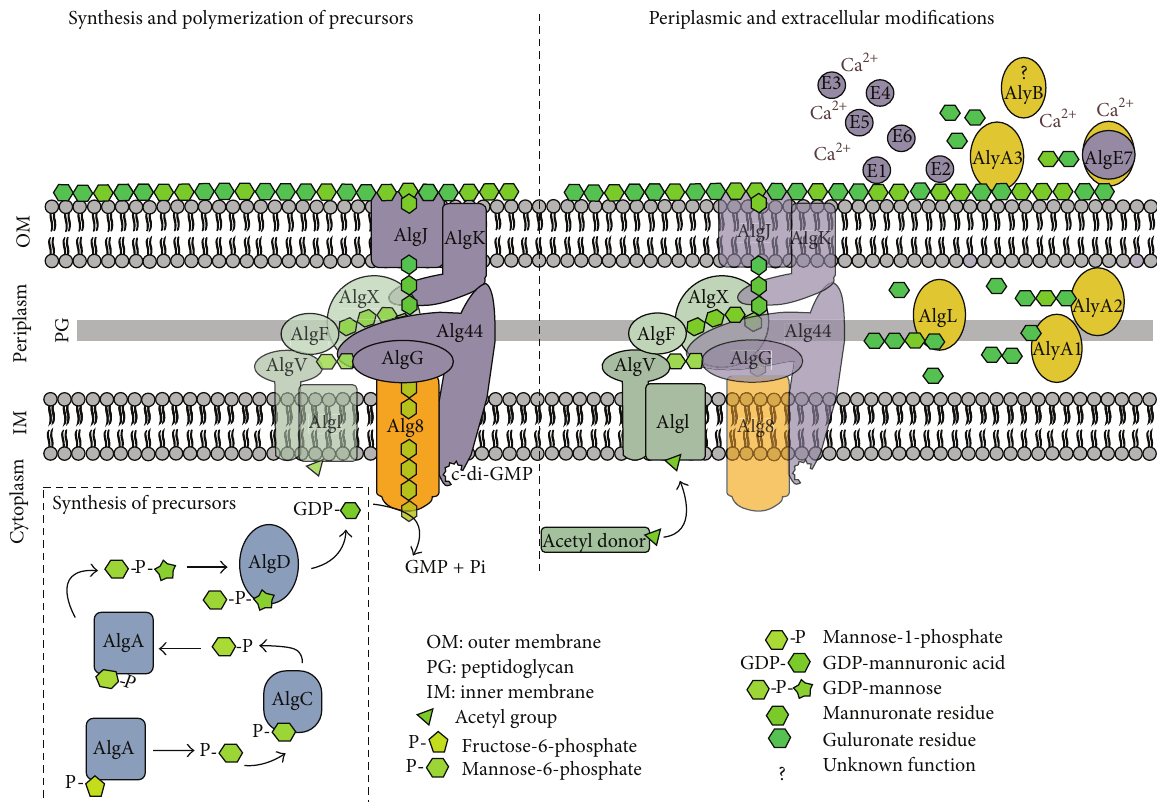
Figure 3: Schematic representation of the alginate biosynthetic steps in Azotobacter vinelandii , from evidence-based protein-protein interaction in P. aeruginosa [28, 42, 43]. The biosynthetic alginate pathway is represented as two complementary stages: on the left, the synthesis of the substrate precursor (GDP-mannuronic acid) and its following polymerization, including transfer from cytoplasm; on the right, the modification (periplasmic and extracellular) of the nascent polymer, as well as the export through the outer membrane of the